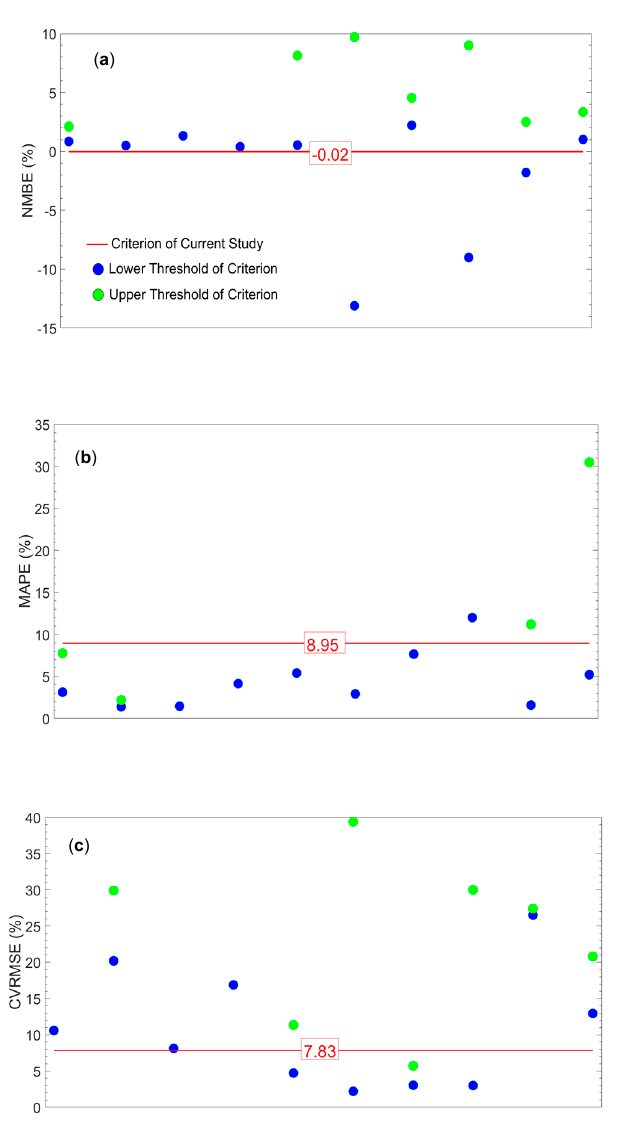
Figure 9. Comparison of the error criteria with 10 recent studies. ( a ) NMBE (Adapted from Refs. [8,17,30–36]) ( b ) MAPE (Adapted from Refs. [8–15,17,37]) ( c ) CVRMSE (Adapted from Refs.